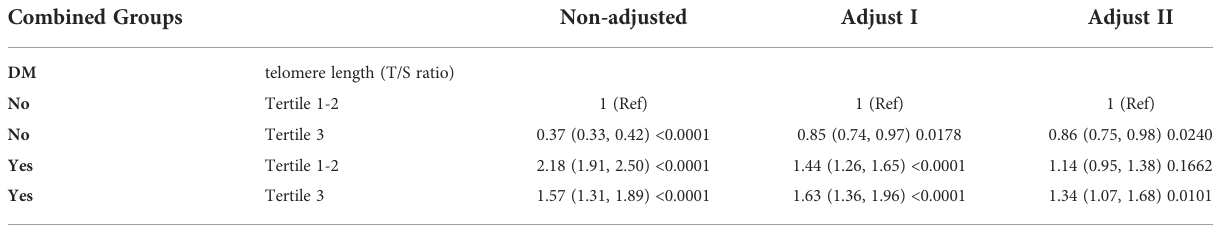
TABLE 3 Joint effects of baseline telomere length (Tertile 1-2 vs Tertile 3) and status of diabetes (Yes, No) on all-cause mortality. Combined